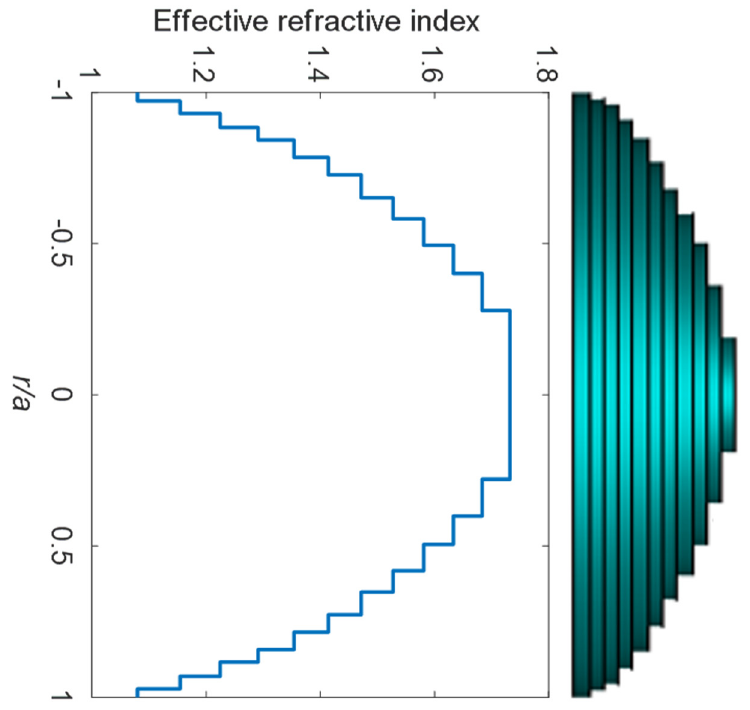
Figure 3. The graded effective refractive index of eleven dielectric slabs, with aperture area diameter, a = 64 mm, and slab thickness, t ∆ = 1 mm.